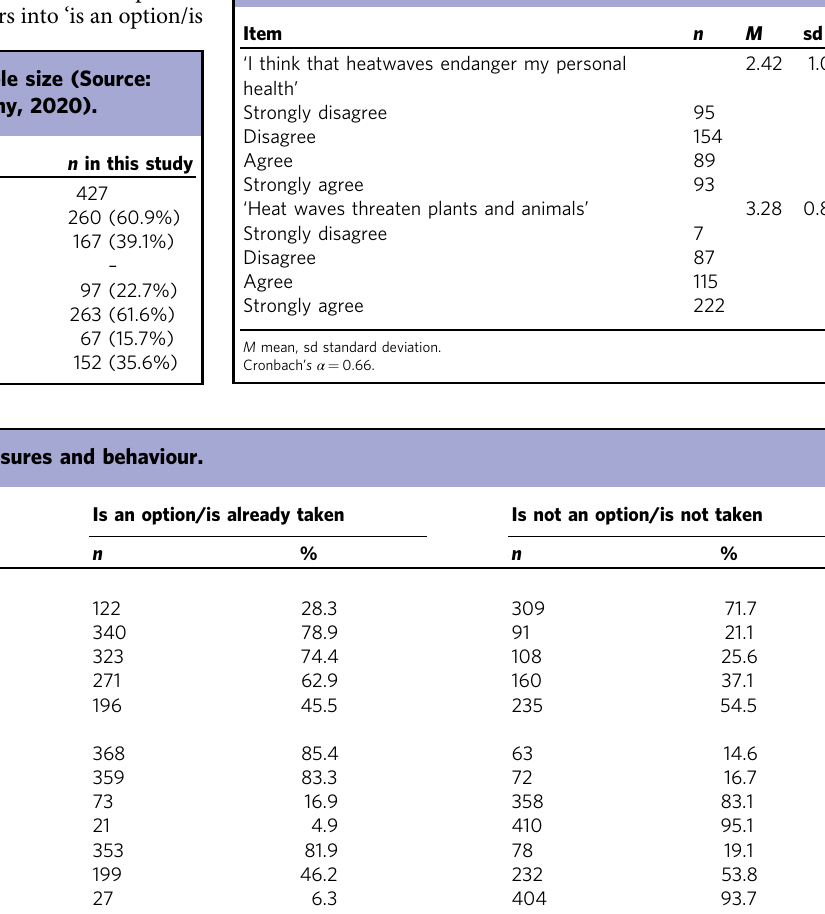
Table 3 Heat Risk Perception item and